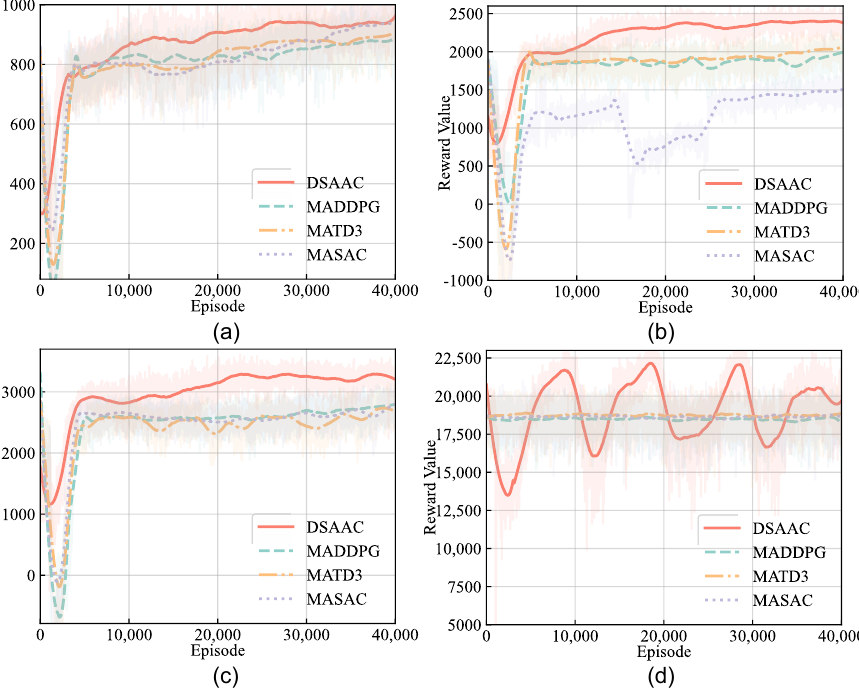
Figure 8. The training curve of reward for different numbers of UAVs: ( a ) 3 UAVs serving 10 GUs; ( b ) 6 UAVs serving 10 GUs; ( c ) 8 UAVs serving 10 GUs; ( d ) 18 UAVs serving 30